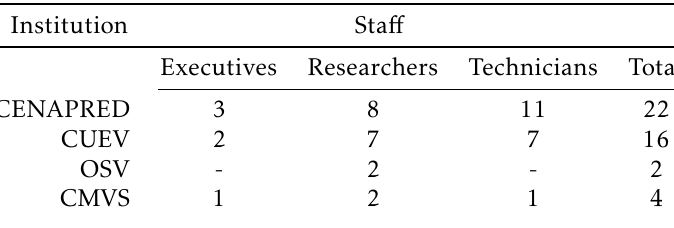
Table 2: Staff dedicated to volcano